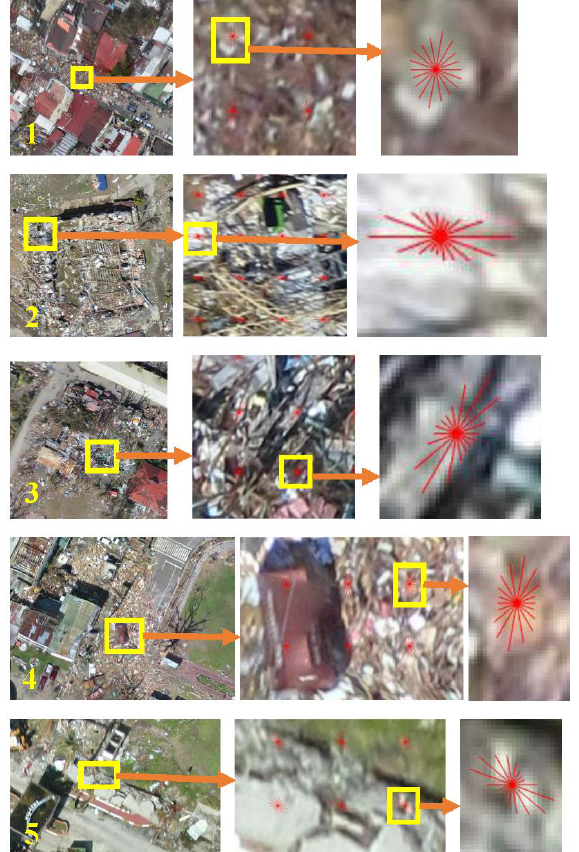
Figure 2. 1-5) UAV images and their corresponding HOG vector results for the denoted